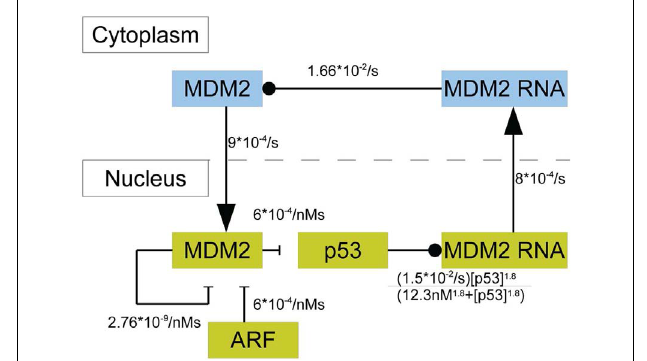
FIGURE 3 |A schematic of the model of p53 including MDM2 sequestration byARF. The blue boxes denote molecular species in the cytoplasm.The yellow boxes indicate molecular species in the nucleus. Arrows denote movement between compartments, barred lines indicate degradation, and circles indicate inducing